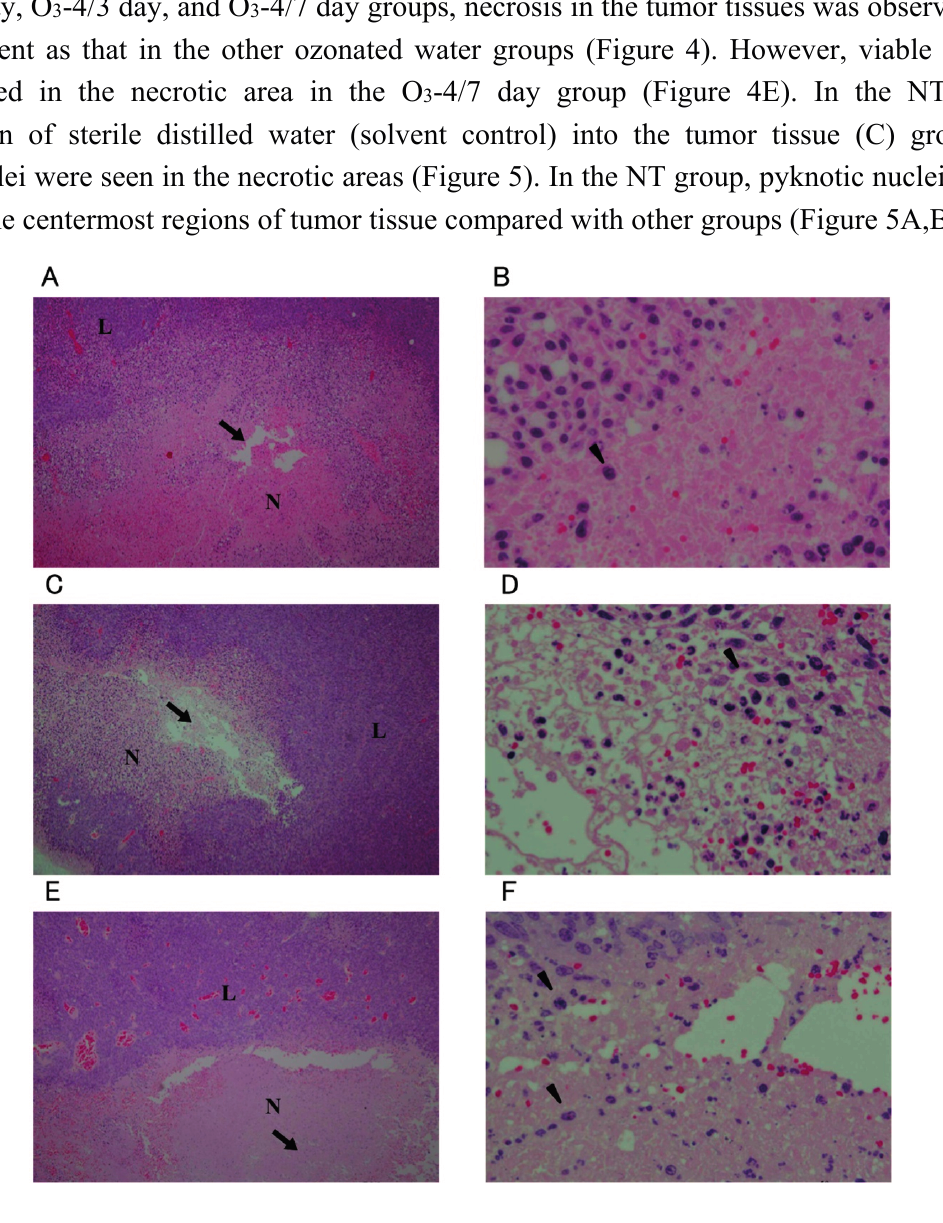
Figure 3. Histological images of tumors 1 day after administration of 20.8, 41.6, or 104 mM ozonated water. Low magnification (40×): ( A , C , E ); High magnification (400×): ( B , D , F ). The concentration of ozonated water was 20.8 mM ( A , B ); 41.6 mM ( C , D ); or 104 mM ( E , F ). All sections were stained with hematoxylin and eosin. N: necrotic area; L: viable tumor area; arrow: site of injection; arrowhead: pyknotic